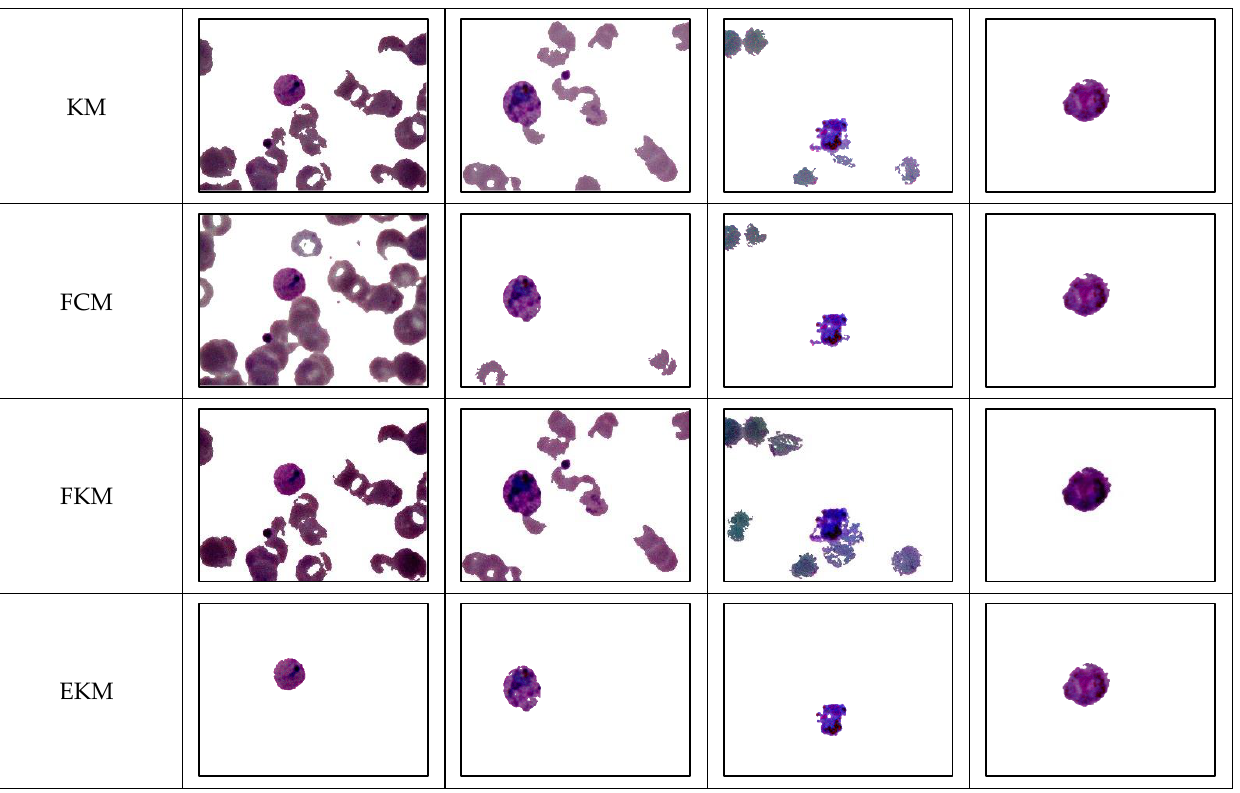
Figure 7. P. vivax of thin smear in the ring, mature trophozoite, schizont, and gametocyte in various segmentation techniques.